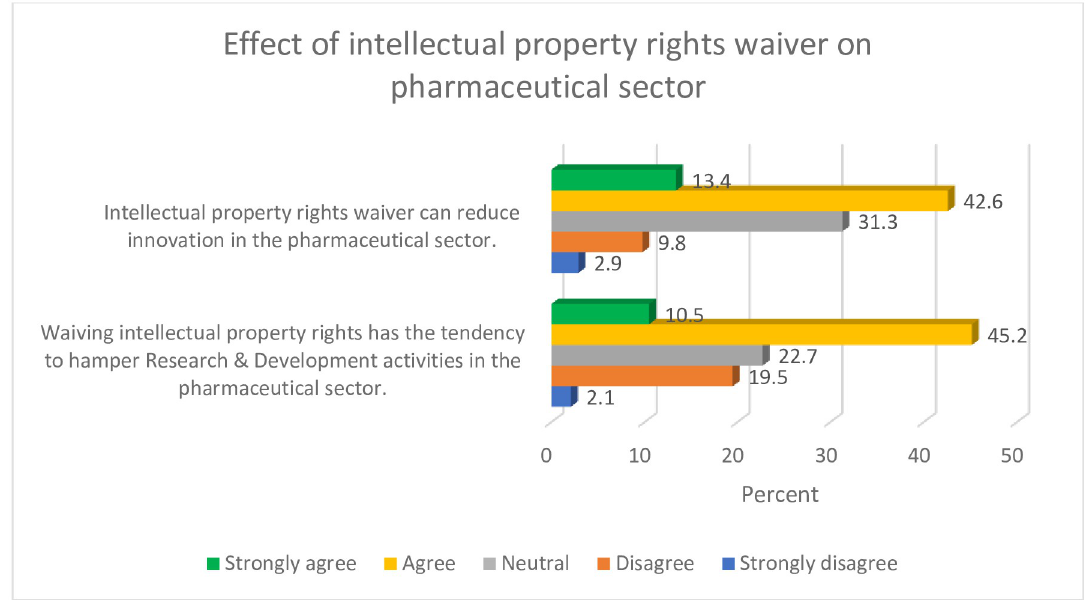
Fig 3. Effect of intellectual property rights waiver on pharmaceutical sector.